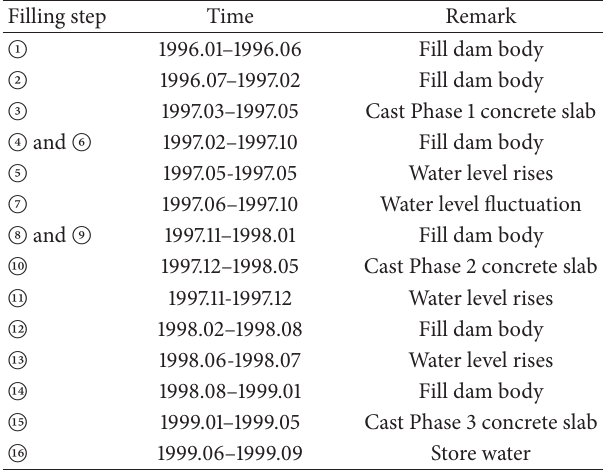
Table 2: Construction stages and